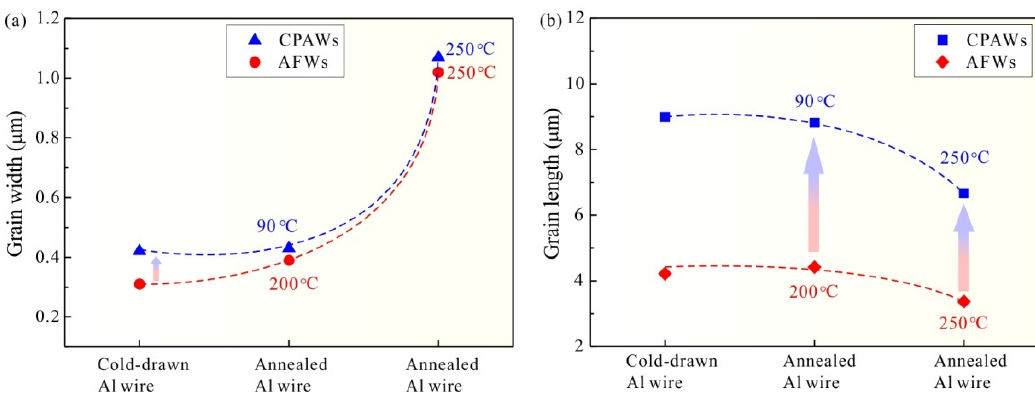
Figure 8. Grain widths ( a ) and grain lengths ( b ) of the cold-drawn CPAW, the annealed CPAWs, the cold-drawn AFW and the annealed AFWs.